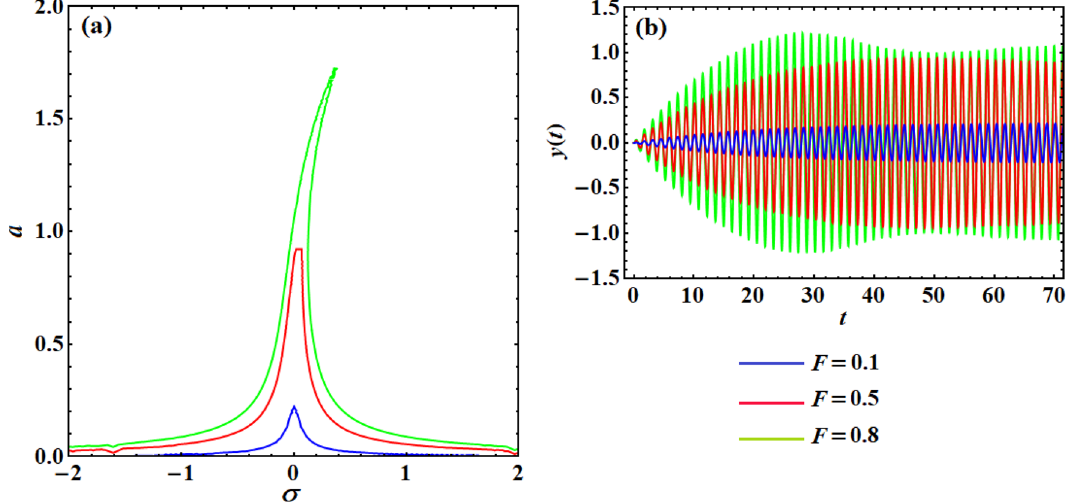
Figure 7. ( a ) Represents the frequency–response’s curves of the uncontrolled system at F ( = 0.1, 0.5, 0.8 ) , while ( b ) shows the time histories of the system according to plotted curves of ( a ) at σ = 0 for the same values of F